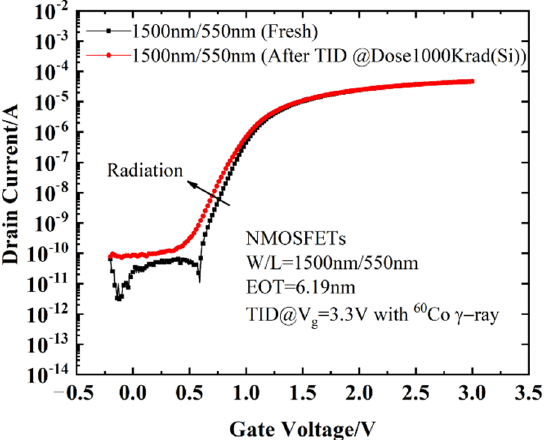
Figure 2. Drain current as a function of gate voltage for devices before and after TID radiation. The W / L of the devices is 1.5 μ m/0.55 μ m. W / L of the devices is 1.5 µ m/0.55 µ